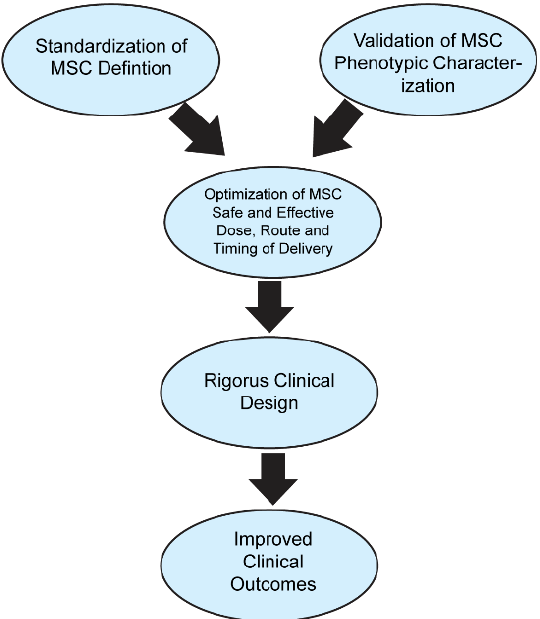
Figure 2. MSC standardization and optimization leading to improved functional outcomes. The standardization of the treatment and classification of MSCs combined with the standardization of MSC administration can increase their clinical applications in clinical trials and settings, which may lead to improved functional outcomes.